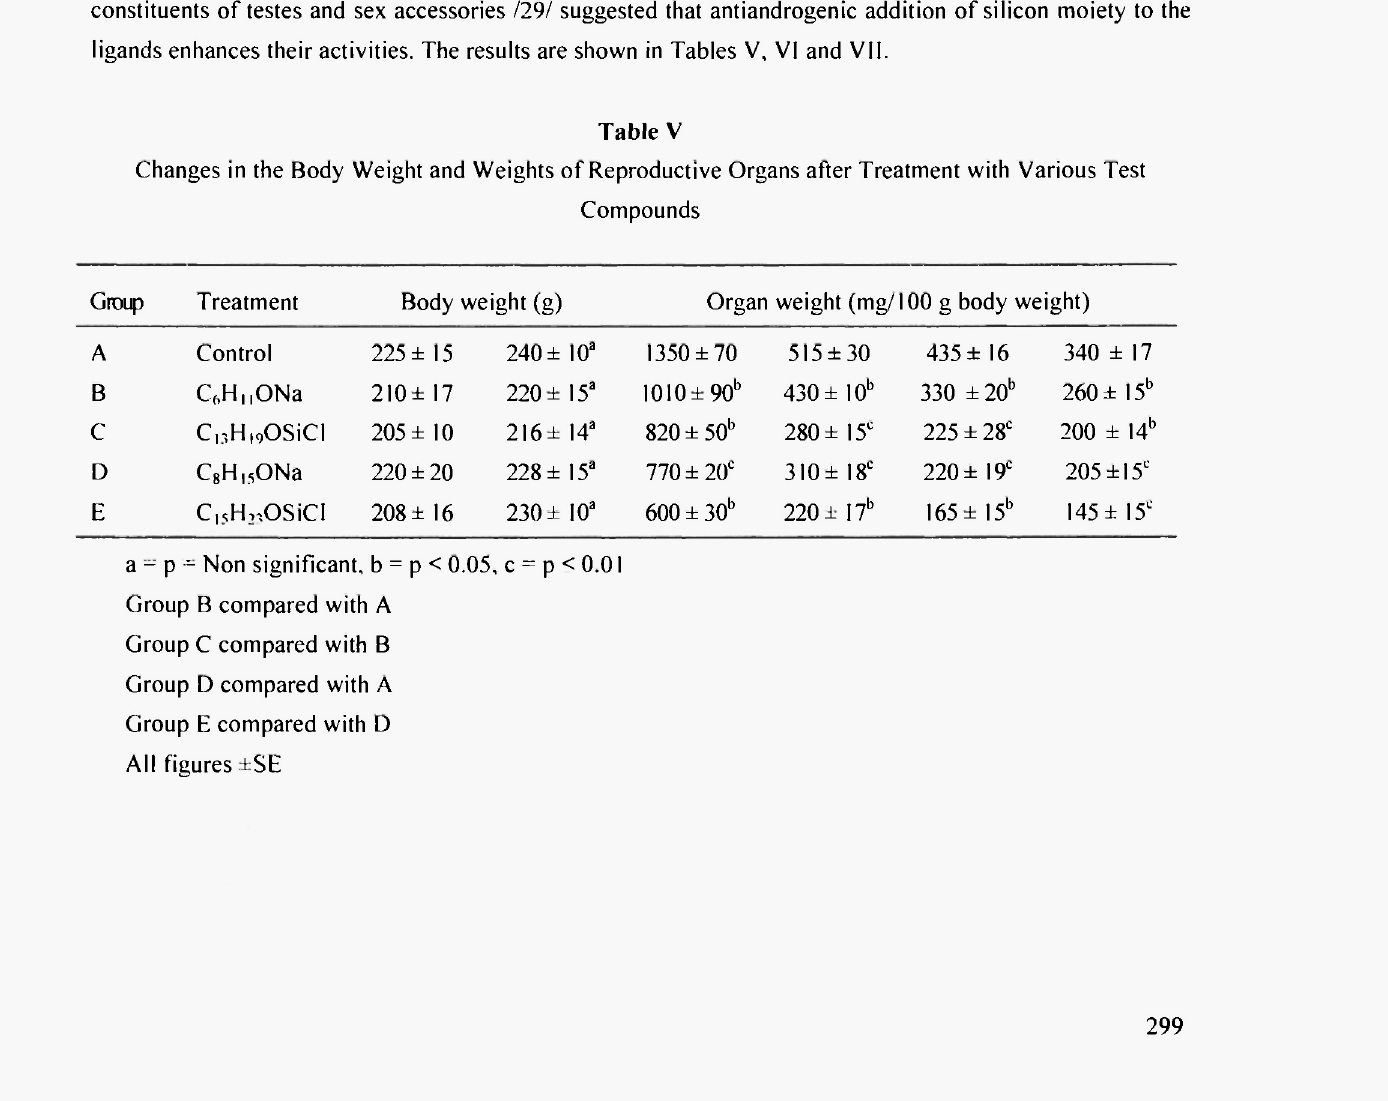
Changes in the Body Weight and Weights of Reproductive Organs after Treatment with Various Test